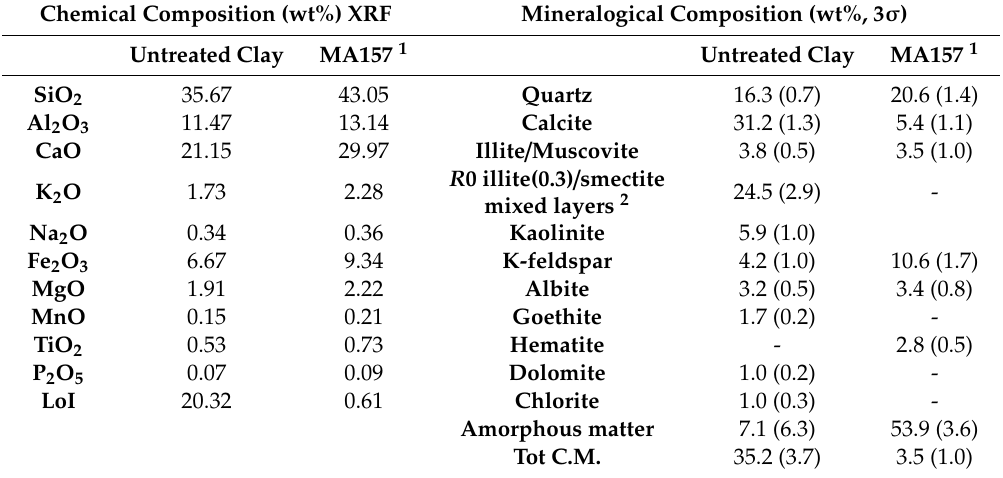
Table 1. Bulk chemical composition and mineralogical content of the original untreated clay and pre-treated MA157.